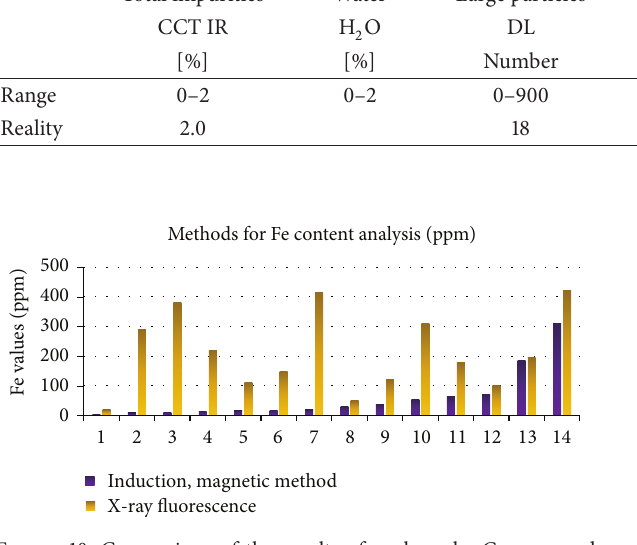
Figure 10: Comparison of the results of analyses by Cosmos and XRF